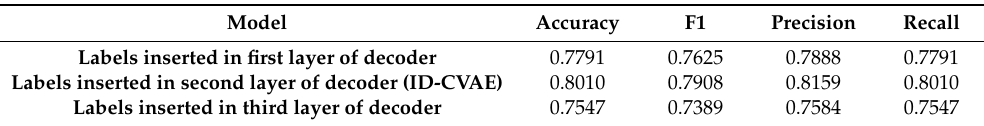
Table 2. Impact of layer used in the decoder to insert the